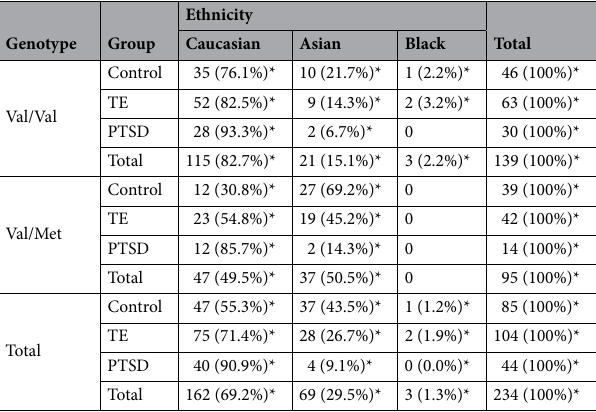
Table 3. BDNF genotype and ethnicity frequency distribution across groups. *% within group.